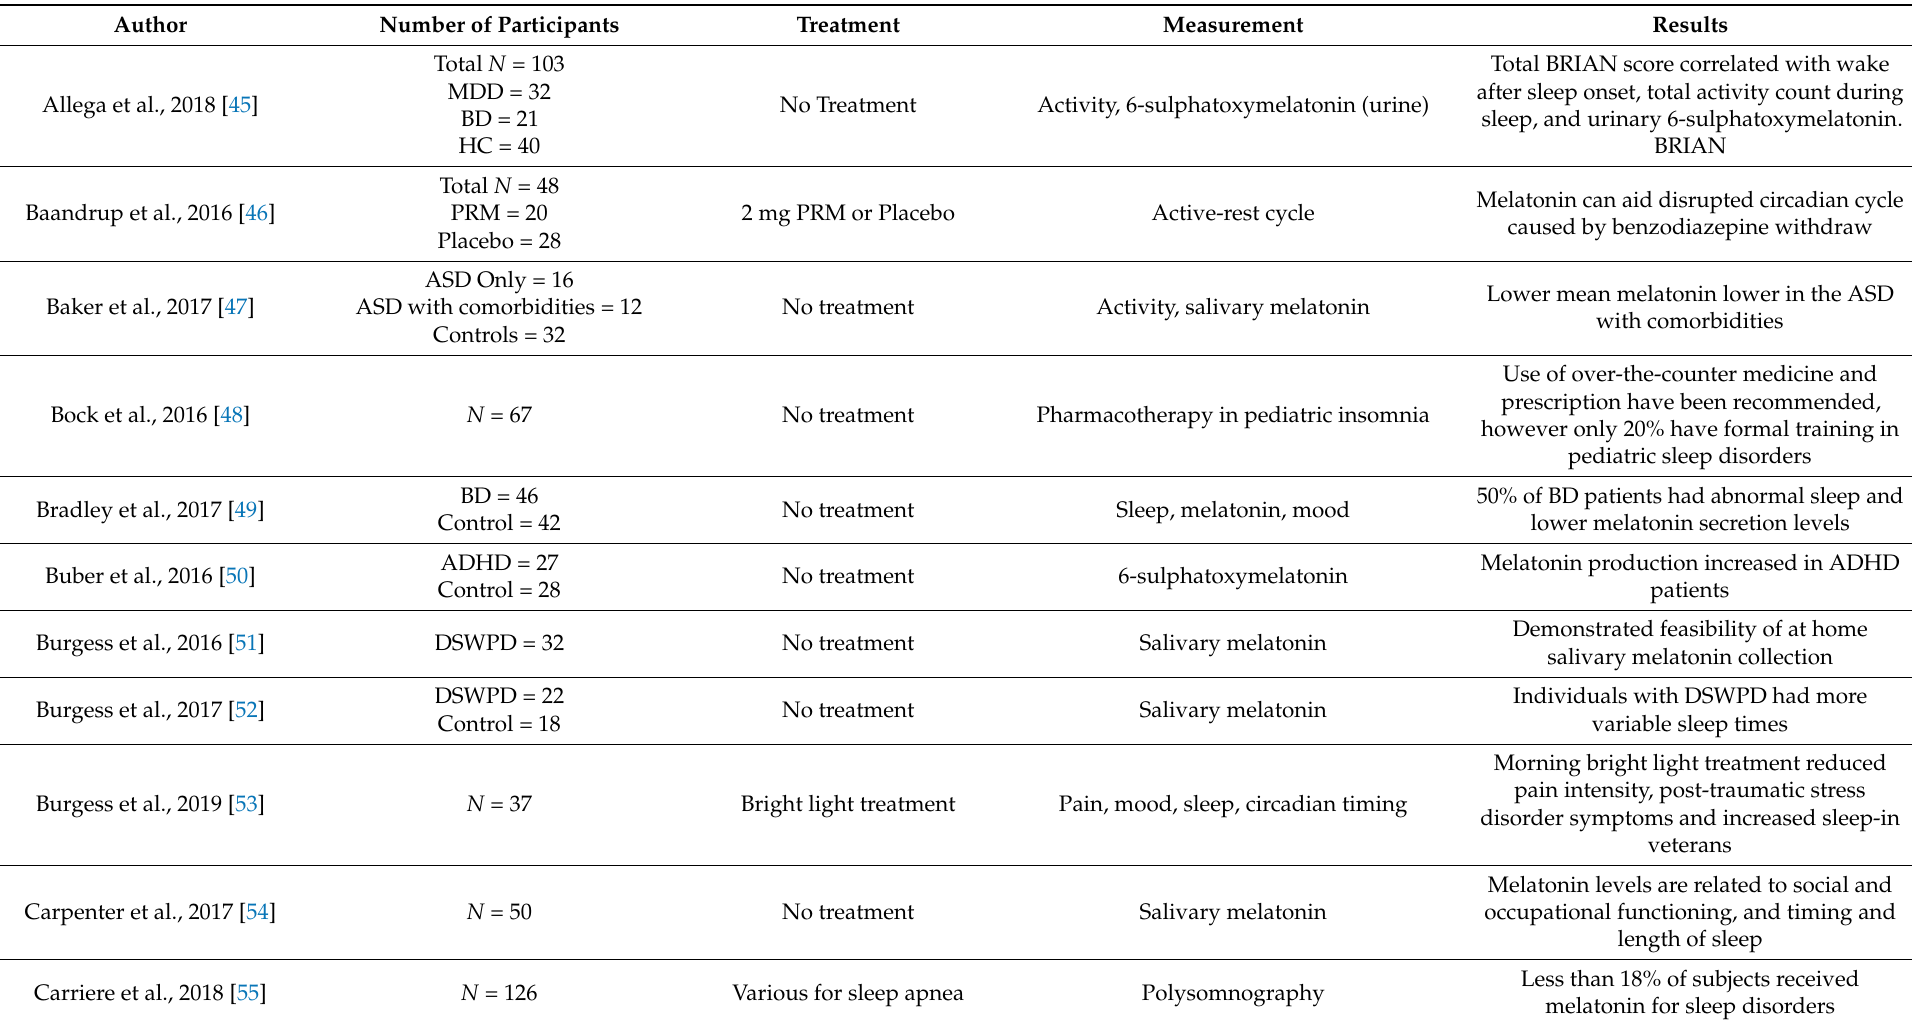
Table 1. Literature Search